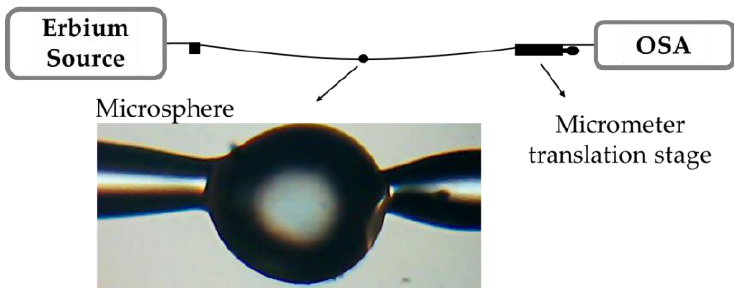
Figure 2. Experimental setup scheme of head sensor based on microsphere coupled between the short taper.